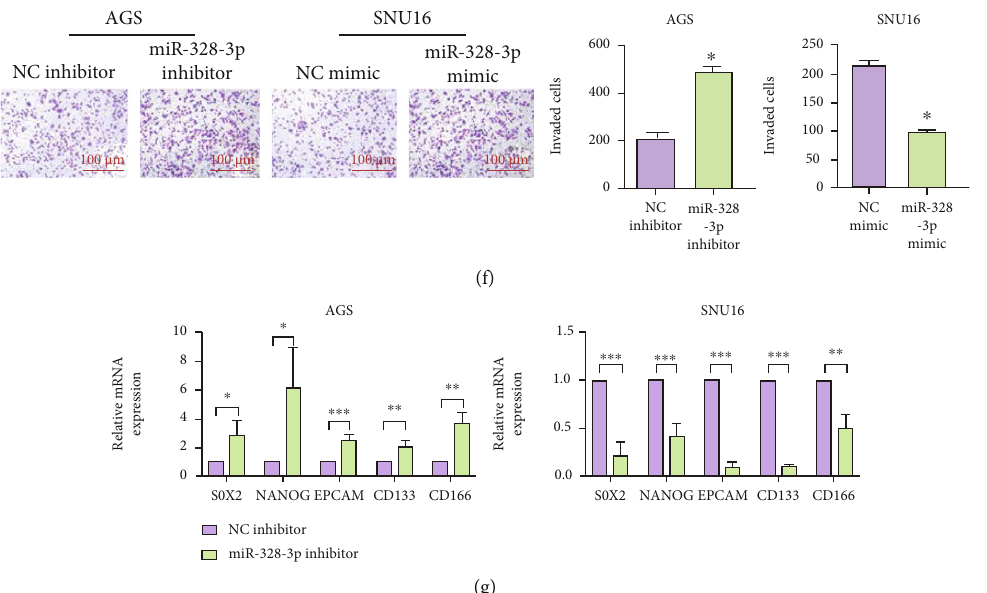
Figure 2: miR-328-3p suppressed the malignant features of STAD cells. To evaluate the functional role of miR-328-3p in STAD, AGS cells were transfected with miR-328-3p inhibitors and SNU16 cells were treated with miR-328-3p mimics. (a) The transfection e ffi ciency of miR- 328-3p detected by qRT-PCR. (b, c) The proliferation of AGS and SNU16 cells was detected with (b) CCK-8 and (c) EdU assays. (d) Western blot assay was employed to detect the expression levels of apoptosis-related proteins. (e, f) The migration and invasion of STAD cells were assessed by (e) wound healing and (f) Transwell assays. (g) qRT-PCR analysis of the expression levels of stem landmarks. Scale bar = 100 μ m. All experiments were performed in triplicate. ∗ P < 0 : 05 , ∗∗ P < 0 : 01 , and ∗∗∗ P < 0 : 001